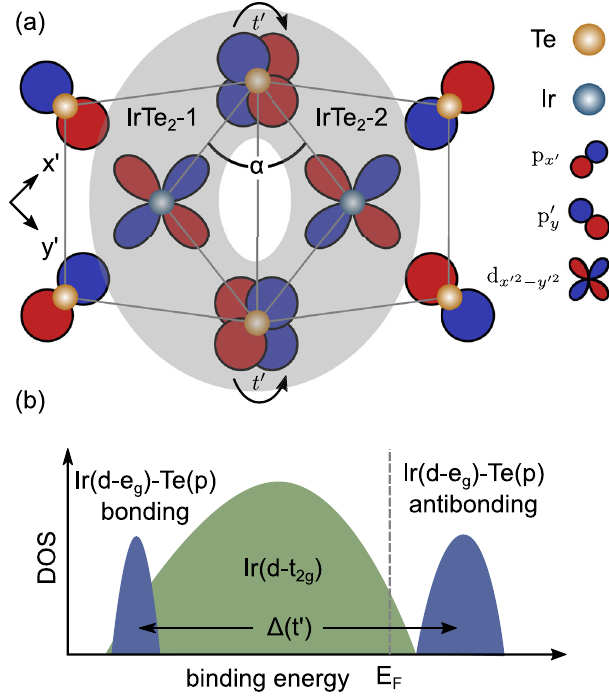
Fig. 7 Schematic illustration of the bonding mechanism. a Bonding geometry between the two edge-sharing IrTe 6 -octahedra (IrTe 6 -1 and IrTe 6 -2) forming the dimer. As α deviates from 90 ∘ , the overlap t 0 between the Te- p orbitals on the shared Te-sites increases and a 4-center bonding orbital can form (light gray ring). b The overlap t ′ determines the energy splitting between bonding and anti-bondig states. Note, the coordinate system in ( a ) x 0 ; y 0 is rotated by 45 ∘ with respect to the coordinate system shown in Fig. 6 (plane